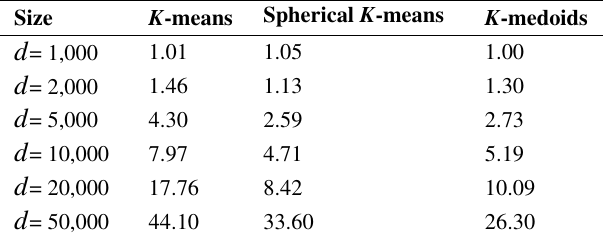
Table 2 The comparison of the run time on the artificial data Size K -means K